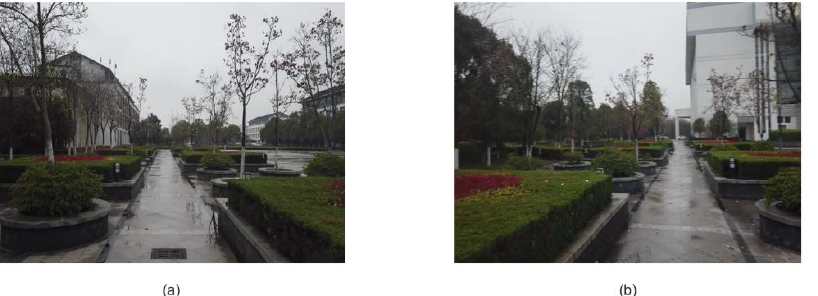
Figure 12. The image frame at the connected interface: ( a ) picture taken by the robot at one end of the road; ( b ) picture taken by the robot at the other end of the road.